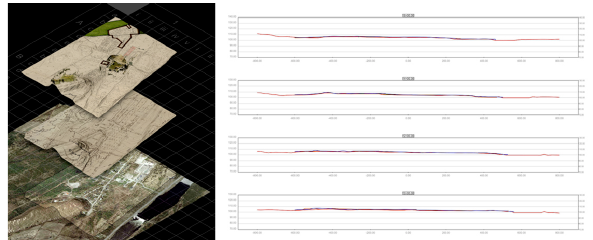
Figure 10. Comparison of the terrain models in rendered 3D and graph form (Fai et al.)